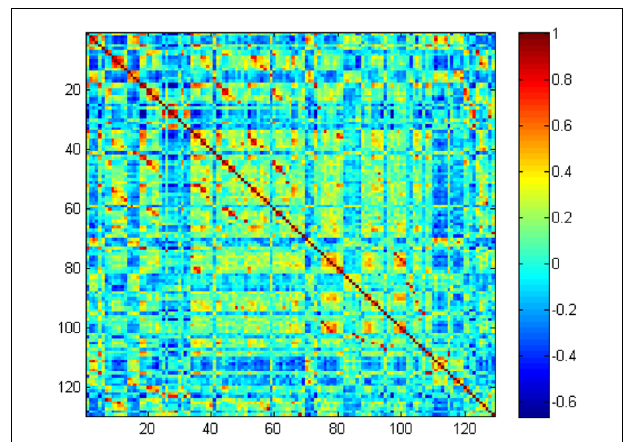
FIGURE 2 | The remaining 129 features correlation heatmap.